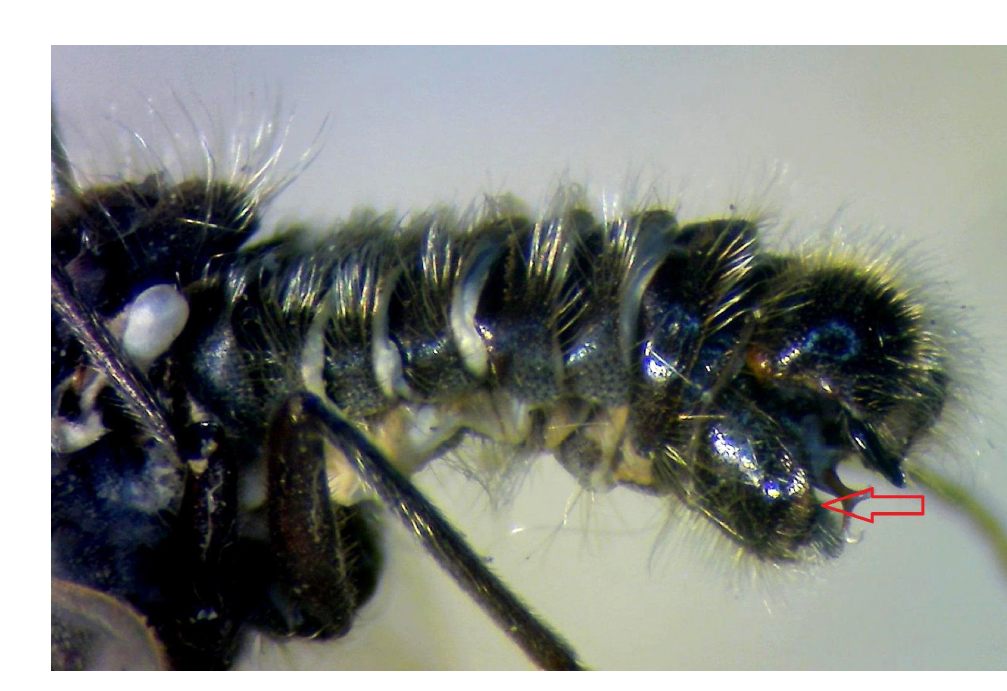
Fig. 16. Parusia almeria gen. et sp. nov.,